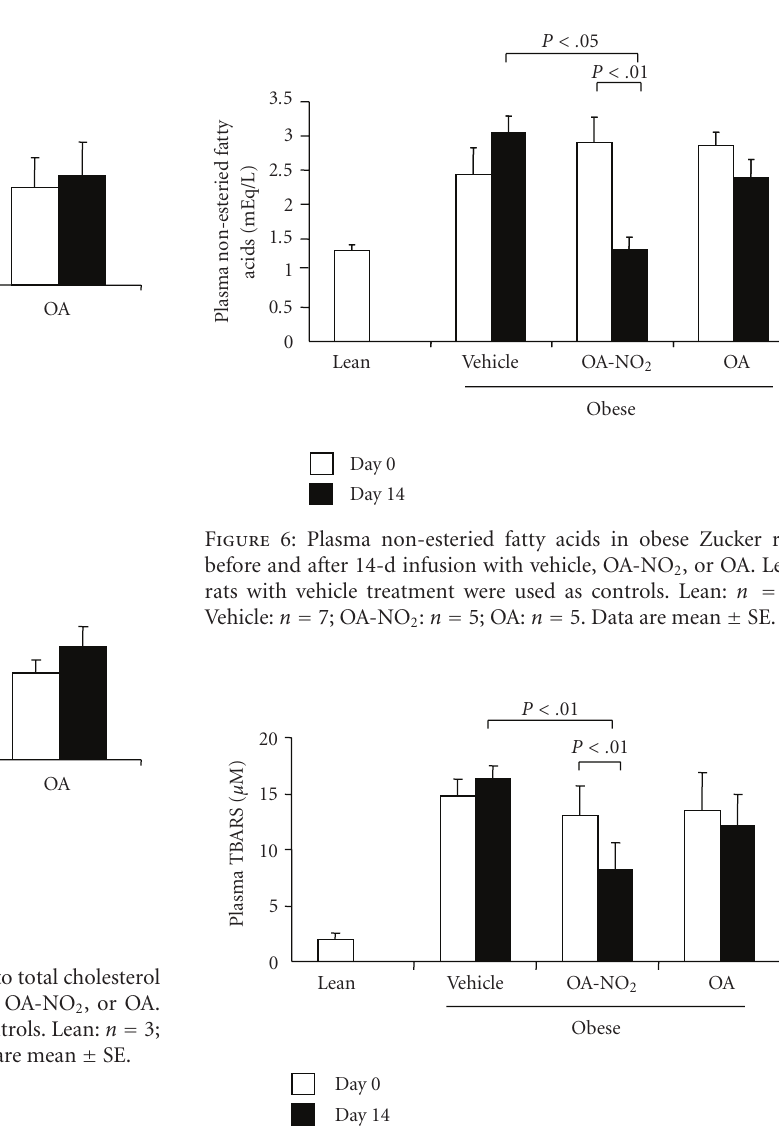
Figure 7: Plasma TBARS in obese Zucker rats before and after 14- d infusion with vehicle, OA-NO 2 , or OA. Lean rats with vehicle treatment were used as controls. Lean: n = 3; Vehicle: n = 7; OA- NO 2 : n = 5; OA: n = 5. Data are mean ± SE.